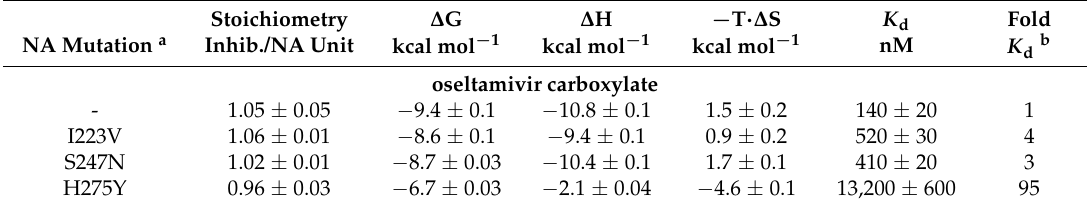
Table 3. Thermodynamic parameters of oseltamivir carboxylate binding to wild-type NA2009